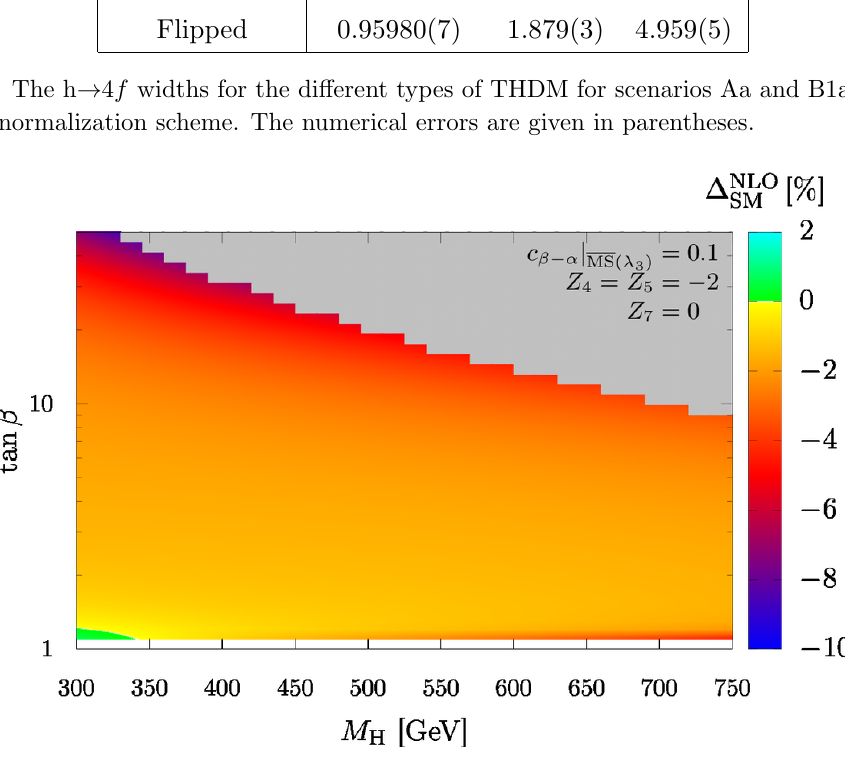
Figure 33 . The relative deviation (cid:1) SM of the h ! 4 f width w.r.t. the SM at NLO for the benchmark plane scenario in the MS( (cid:21) 3 ) scheme. Gray areas are excluded by non-perturbativity while the size of the deviations is indicated by the colour. We interpolate linearly between computed points to obtain a smooth